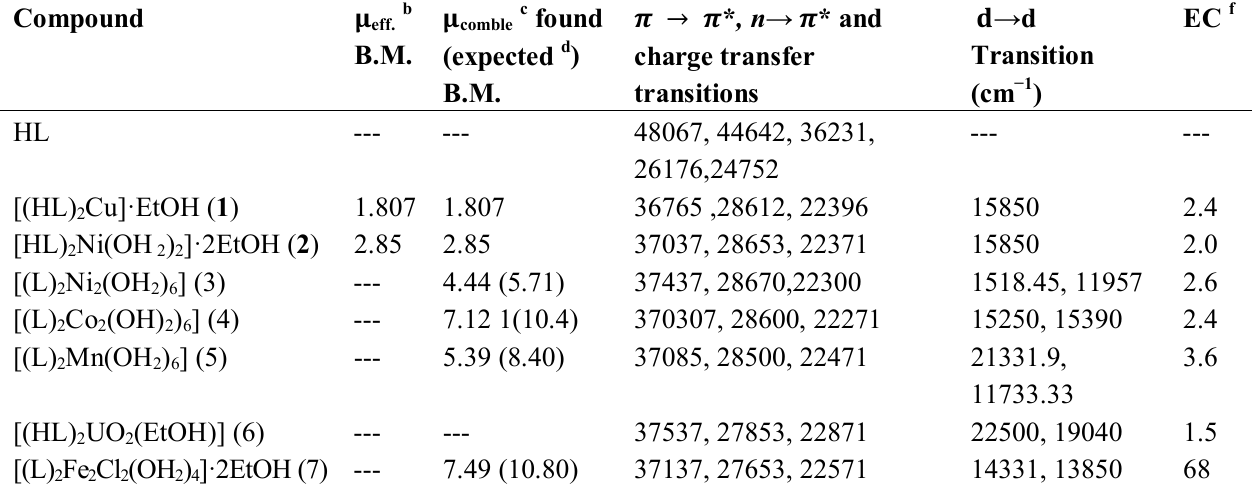
Table 4. Magnetic moment, electronic and conductance measurements spectral data (cm − 1 ) for HL and its metal complexes a